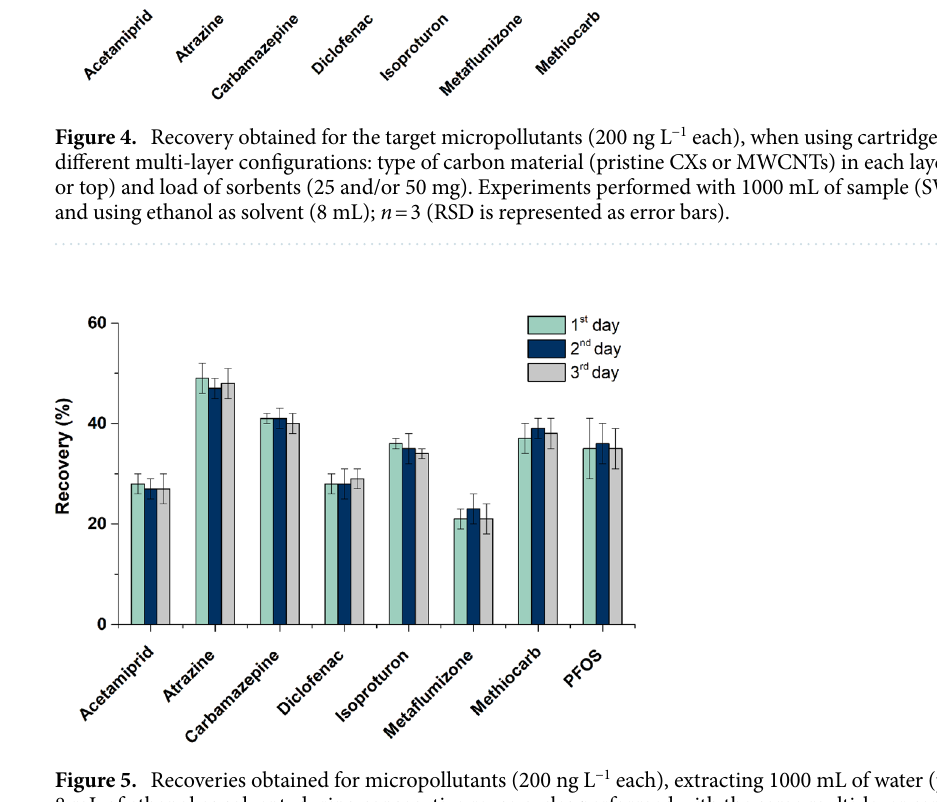
increases around 20% with the lower quantity of sorbent. Similar results were obtained for the other target OMPs regardless of the sorbent load, that may be explained by a more difficult desorption of this compound during the elution step, when higher amounts of CX were packed in the cartridges . The recoveries obtained with the best multi-layer carbon-based cartridges particularly when considering metaflumizone (bottom: 25 mg of CXs; top: 25 mg of MWCNTs), were compared with those previously obtained with CXs and MWCNTs cartridges independently (Figure S8). A non-cumulative effect is observed, since the recoveries obtained when the two carbon materials are packed together in the same cartridge are nearly half of those obtained when CXs (in the case of metaflumizone) and MWCNTs cartridges (for the other 7 OMPs) are used independently. These results may be explained by the stronger adsorption on MWCNTs (in the case of metaflumizone) or on CXs (in the case of the other 7 OMPs), which hinders the desorption step (Table S9) and leads to a decrease in the recovery values (i.e., when comparing the performance of multi-layer cartridge with the single-layer cartridges packed with each carbon material). Only the multi-layer carbon-based SPE cartridge is able to extract in a single procedure the 8 target OMPs simultaneously. Although the recoveries are low (> 20%), the procedure was proved to be very precise (RSD < 6%). Additionally, in the literature, there is neither an official guideline nor a consensual recommendation for the recoveries that should be achieved during the development of an analytical methodology. Bearing this in mind and considering the constant recovery values for all analytes over the range of concentrations as well as the proportional response to the internal standards, it was decided to keep these analytes in this study. Therefore, the multi-layer carbon cartridge’s reusability was studied, similar recoveries being obtained for the 8 OMPs during three successive cycles (Fig. 5). These reusability features are characteristic of carbon-based SPE cartridges 36 , representing an advantage when compared to traditional